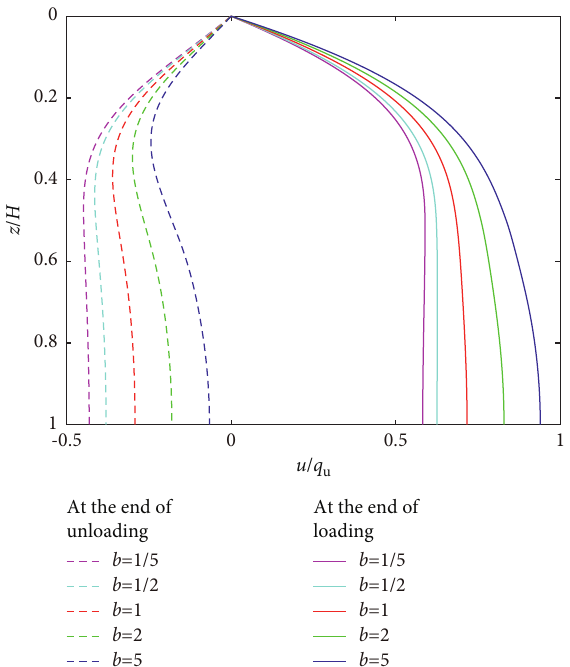
Figure 8: The excess pore pressure isochrones under different values of b